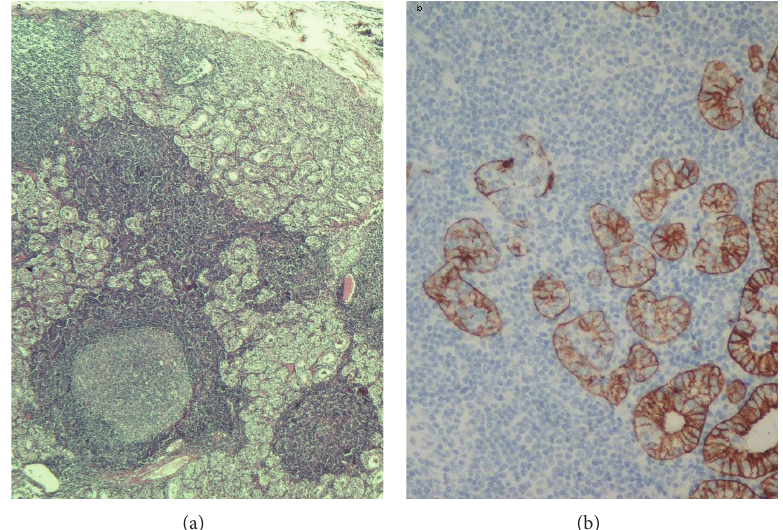
Figure 1: Encapsulated homogenous lesion, composed of clear type chief cells of a microfollicular pattern in delicate capillary network, accompanied by multiple, scattered foci of dense lymphocytic infiltrates with formation of follicles with fully developed germinal centers ((a): HE × 100). Small foci with glandular destruction due to lymphocytic infiltration highlighted by staining with CK8/18 ((b): IHC ×